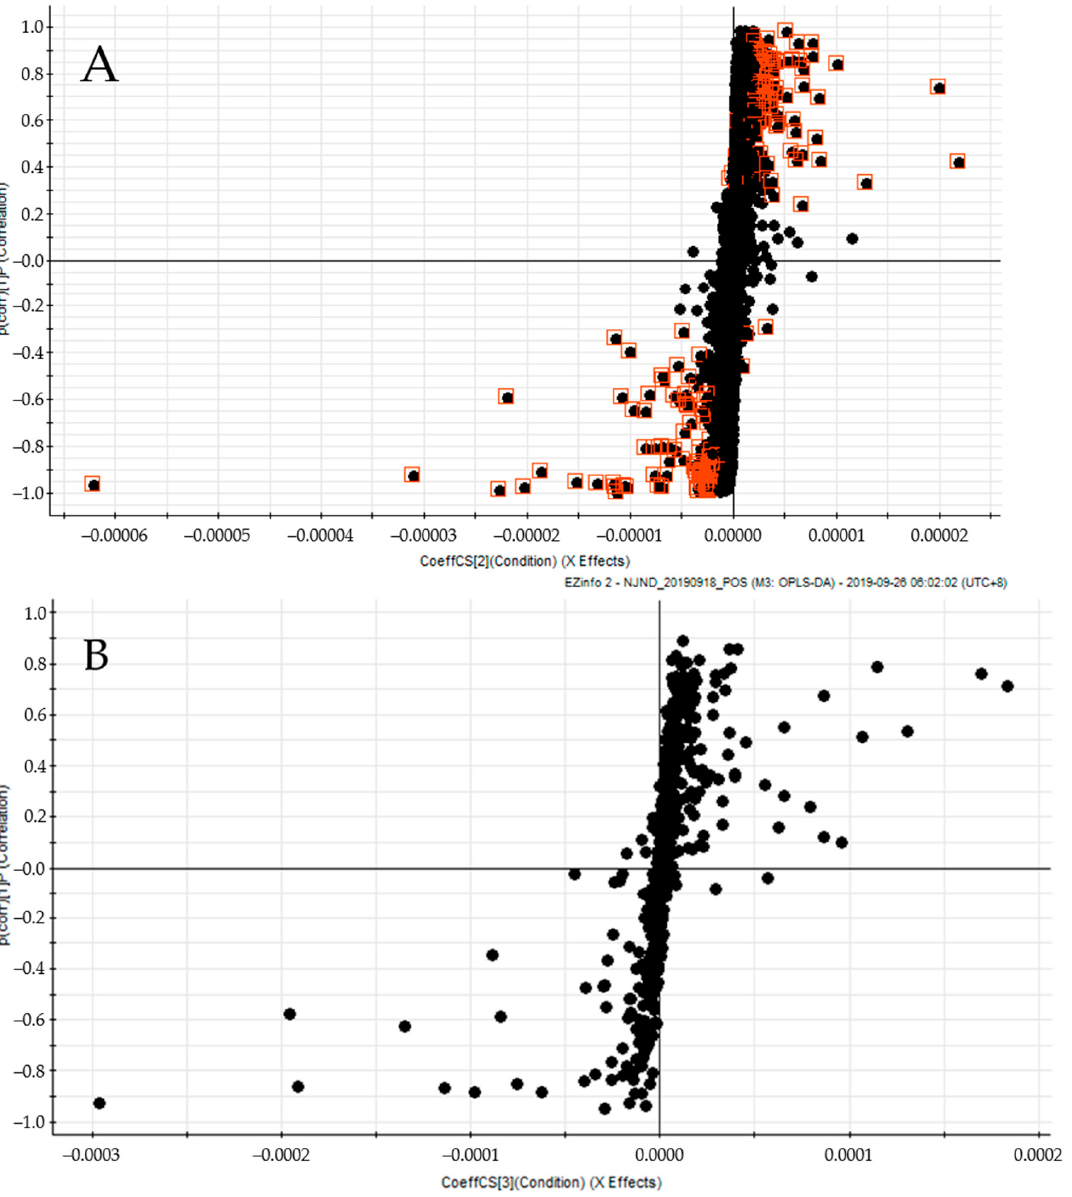
Figure 3. S ‐ Plot (28 March and 13 April). ( A ): S ‐ plot of positive ion mass spectrum; ( B ): S ‐ plot of negative ion mass spectrum. Each circle point represents a variable (metabolite), while the red boxed black points represent all of the different variables that exhibited a significant increase or decrease after dormancy release (28 March and 13 April).